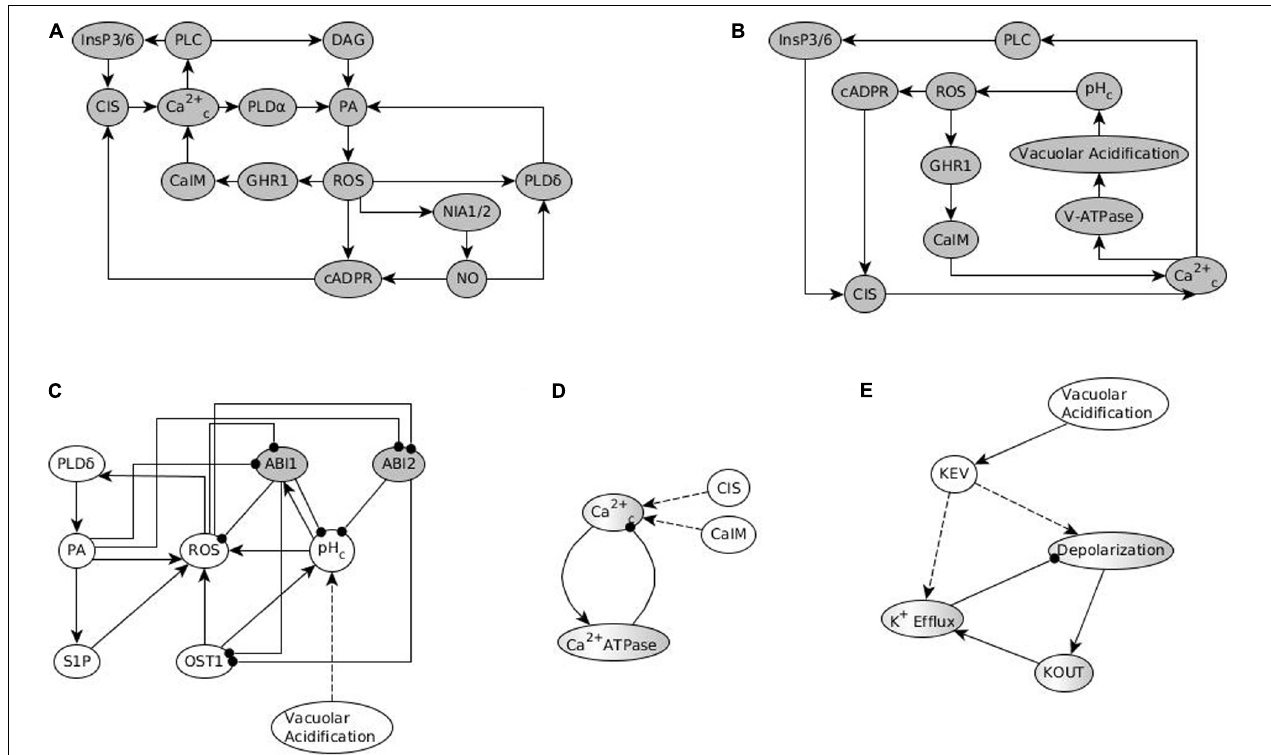
FIGURE 2 | Stable and oscillating motifs observed in the absence of ABA. (A) Stable motif associated with open stomata attractors; we refer to this motif as openM1. (B) Stable motif associated with open stomata attractors; we refer to this motif as openM2 . (C) Conditionally stable motif associated with the closed stomata attractor A0; we refer to this motif as closureM . The condition for this conditionally stable motif is the ON state of Vacuolar Acidification. In panels (A–C) , the white background indicates the ON state of the node and the gray background means OFF state of the node. (D) Conditional oscillatory motif associated with closed stomata. This motif plays a role in both the presence and absence of ABA. The condition for the activation of this motif is the ON state of either of CIS or CaIM, and it yields a sustained oscillation of Ca 2 + c and Ca 2 + ATPase (represented as a gray-white background). (E) Conditional oscillatory motif, K + oscillation , that exists in the absence of any signal. The condition for the activation of this motif is KEV = ON. Since Vacuolar Acidification is sufficient for KEV, the ON state of Vacuolar Acidification is sufficient to establish this conditional oscillating motif, leading to sustained oscillation of its constituent